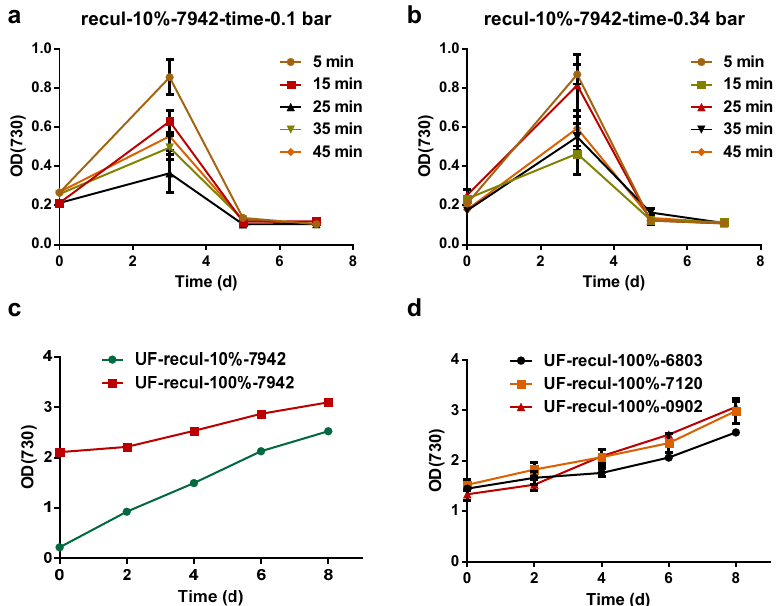
Figure 4. The cyanobacteria growth curve after membrane filtration. ( a , b ) For these experiments, 10 mL of circulating filtered Syn 7942 culture was inoculated into 100 mL of fresh BG11 medium for re-culture after regular intervals of filtration using an MF membrane under a feed pressure of 0.1 bar ( a ) or 0.34 bar ( b ). ( c ) For this experiment, 10 mL of circulating filtered Syn 7942 culture was inoculated into 100 mL of fresh BG11 medium for re-culture, or 100 mL of circulating filtered Syn 7942 culture was directly used for re-culture after 95.5 min of filtration using a UF membrane under a feed pressure of 1 bar. ( d ) For this experiment, 100 mL of circulating filtered Syn 6803, Ana 7120, and Lep 0902 culture was directly used for re-culture after 95.5 min of filtration using a UF membrane under a feed pressure of 1 bar. The OD730 of cyanobacteria used for filtration was 1.5–1.8. Error bars represent the standard deviations of triplicates.